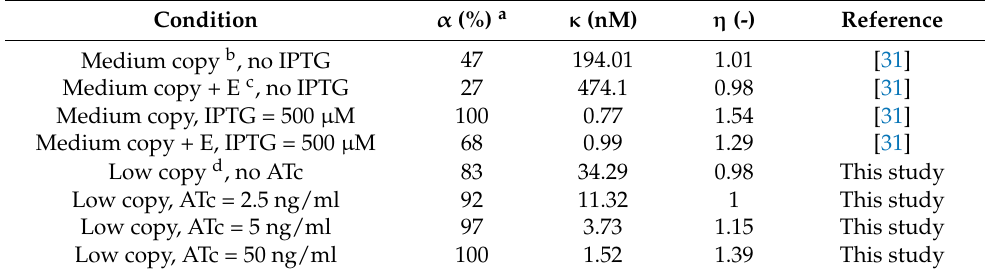
Table 2. Parameters estimated from in vivo experiments. Measurements were carried out using MG1655-Z1 as host